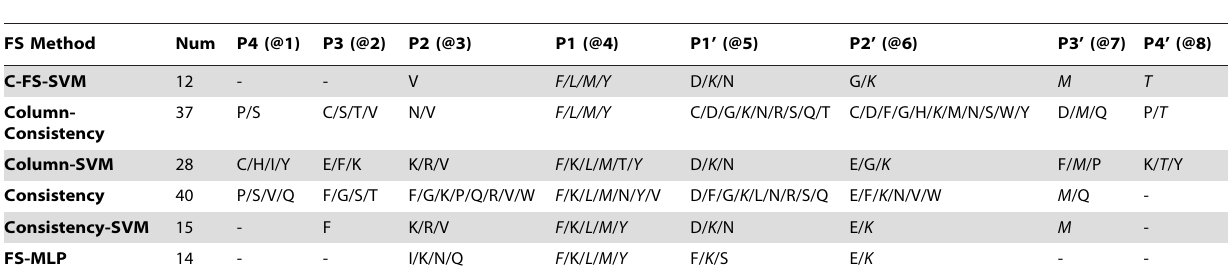
Table 1. Selected attributes according to the FS methods (- indicates no feature is specifically determined for the column).